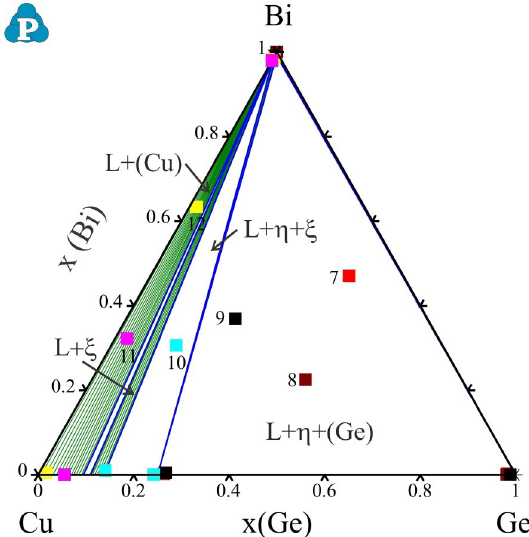
Figure 7. Calculated Bi-Cu-Ge isothermal section at 400 °C compared with the EDS results given in Table 3